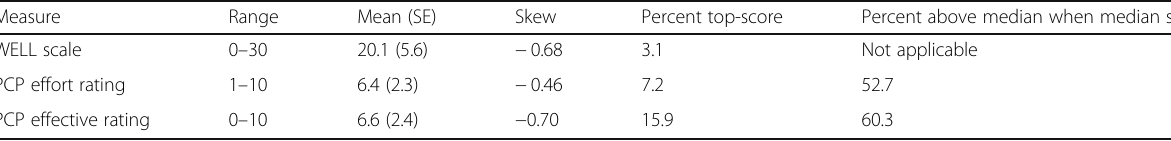
Table 4 Distribution of the WELL scale and PCP ratings